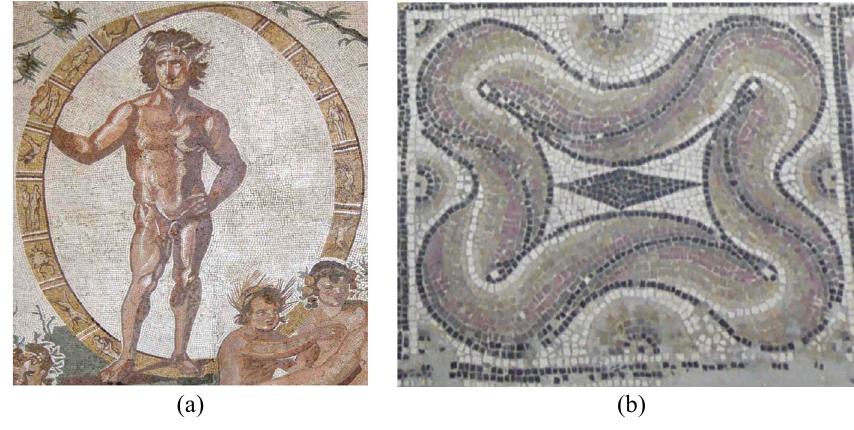
Figure 46. (a) Möbius before Möbius [31] and (b) GML ’ s before the